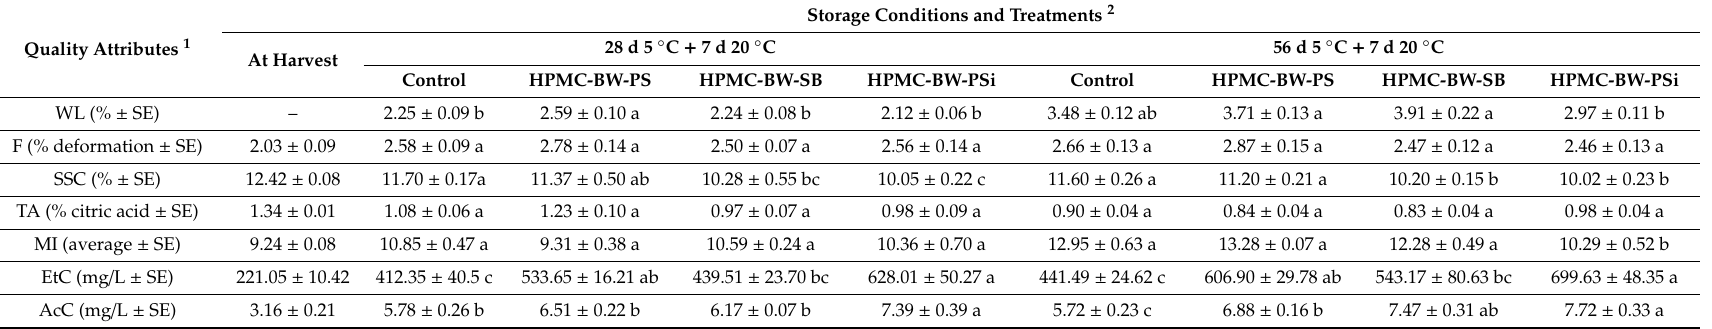
Table 3. Quality attributes of “Valencia” oranges coated with hydroxypropyl methylcellulose (HPMC)-beeswax (BW) edible composite coatings containing GRAS salts and stored at 5 ◦ C followed by 7 d of shelf life at 20 ◦